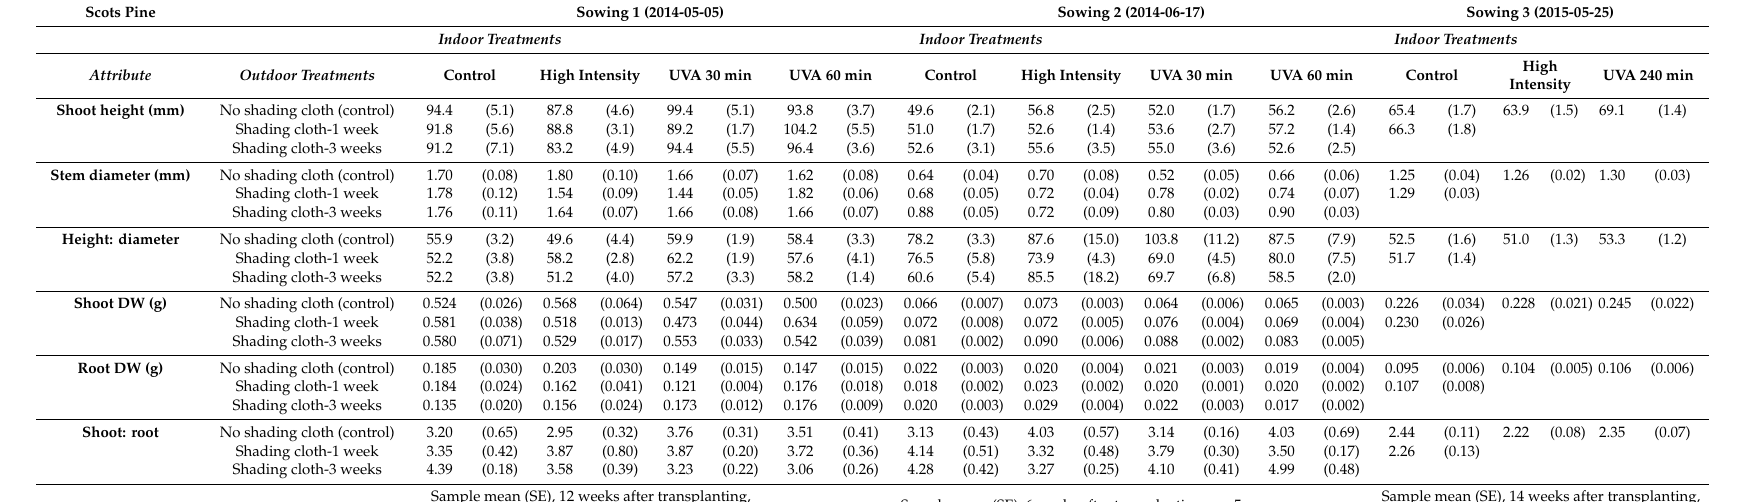
Table A2. Material attributes of Scots pine seedlings after one vegetation